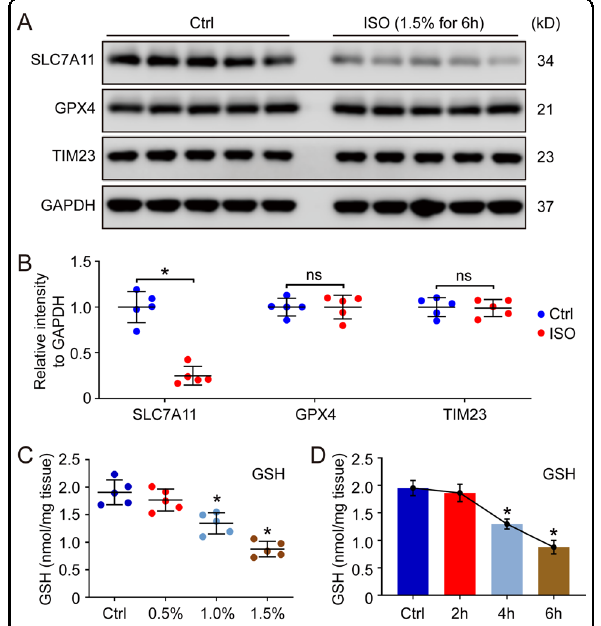
Fig. 2 Iso fl urane induces ferroptosis via affecting system Xc − in hippocampus. After iso fl urane exposure (ISO, 1.5%) for 6 h, the hippocampus was isolated for western blot detection ( A ). The quanti fi cation of western blot was showed in ( B ). Moreover, the effect of iso fl urane exposure on GSH level in hippocampus was also evaluated in different groups ( C , D ). In B , * p value < 0.05 compared between two groups. ns: p value > 0.05 compared between two groups. In C , D , * p value < 0.05 compared with the Ctrl group.